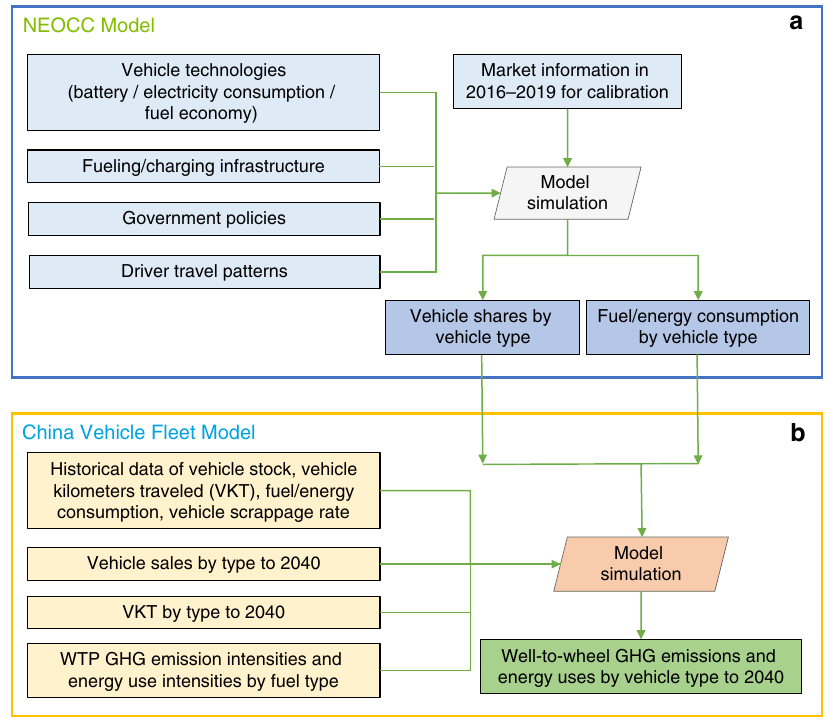
Fig. 5 High-level model diagram with key inputs and outputs. a The data fl ow diagram of the NEOCC Model. The rectangle boxes in light blue show the key inputs of the NEOCC model. The parallelogram box in gray shows the NEOCC model simulation. The rectangle boxes in dark blue show the outputs from the NEOCC model. b The data fl ow diagram of the China Vehicle Fleet Model. Rectangle boxes colored in yellow show the key inputs of the China Vehicle Fleet Model. The NEOCC Model outputs colored in dark blue of a are also used as the inputs of the China Vehicle Fleet Model. The parallelogram box in orange shows the China Vehicle Fleet Model simulation. The rectangle box colored in green shows the fi nal output of the model